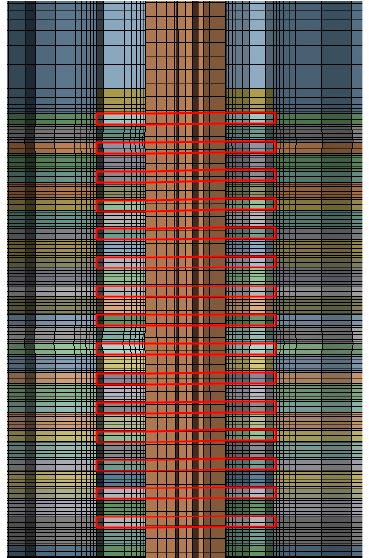
Figure 4. Cross section of the computational mesh through one of the heat pipes.